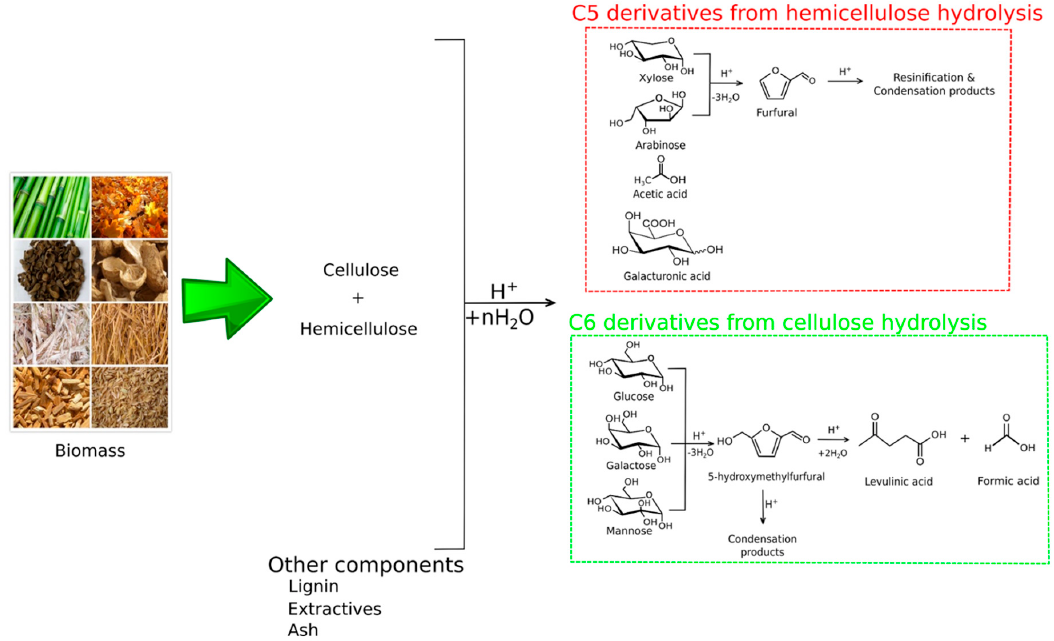
Figure 3. Reaction network of the acid ‐ catalyzed hydrolysis of cellulose and hemicellulose in lignocellulosic biomass.